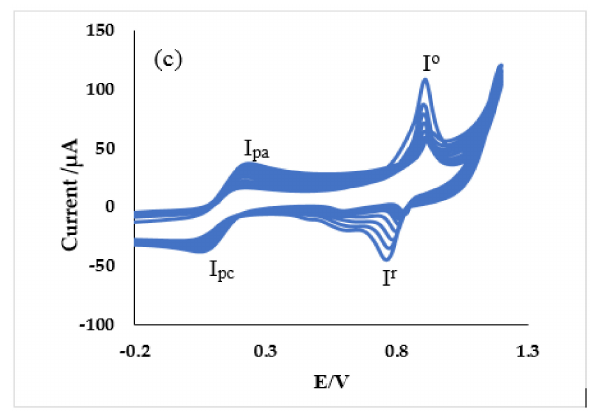
Figure 15. Current response (20 scans) of of (a) SPE / GPE / ZnO NPs / GPE, ( b ) SPE / LPE / ZnO NPs and ( c ) SPE / OPE / ZnO NPs in 10 mM K 3 [Fe(CN) 6 ] prepared in 0.1 M KCl at pH ≈ 7 at the scan rate of 25 mV / s.